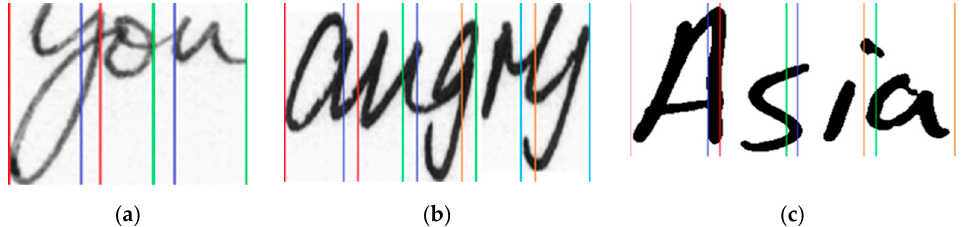
Figure 6. Pictorial representation of the vertical zoning process with overlapping columns considering three input images ( a – c ). Vertical lines of the same color indicate the beginning and end of a zone. Consecutive vertical zones always have an overlapping region in between them.